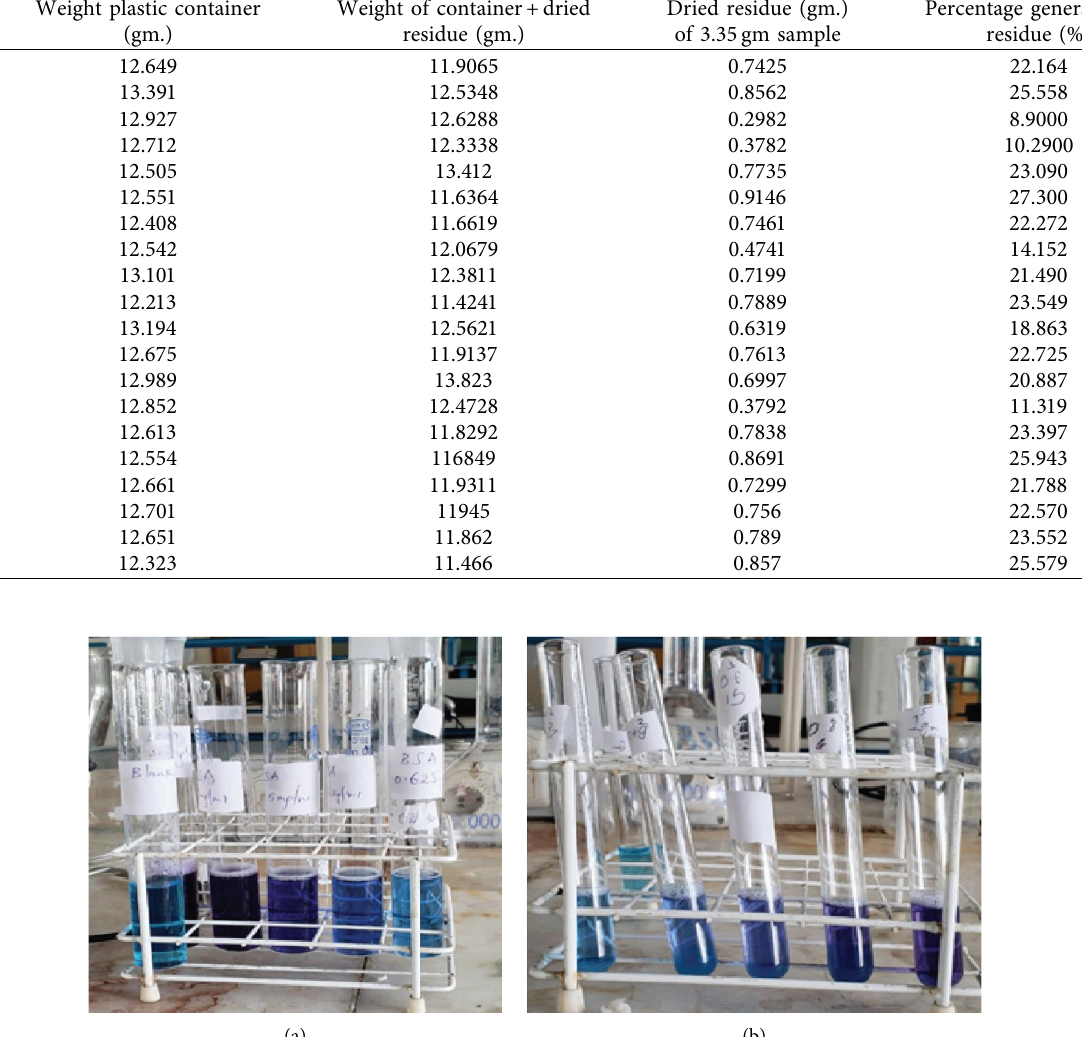
Table 4: Analysis result for percentage generation of residue and extract after centrifuging. Weight plastic container